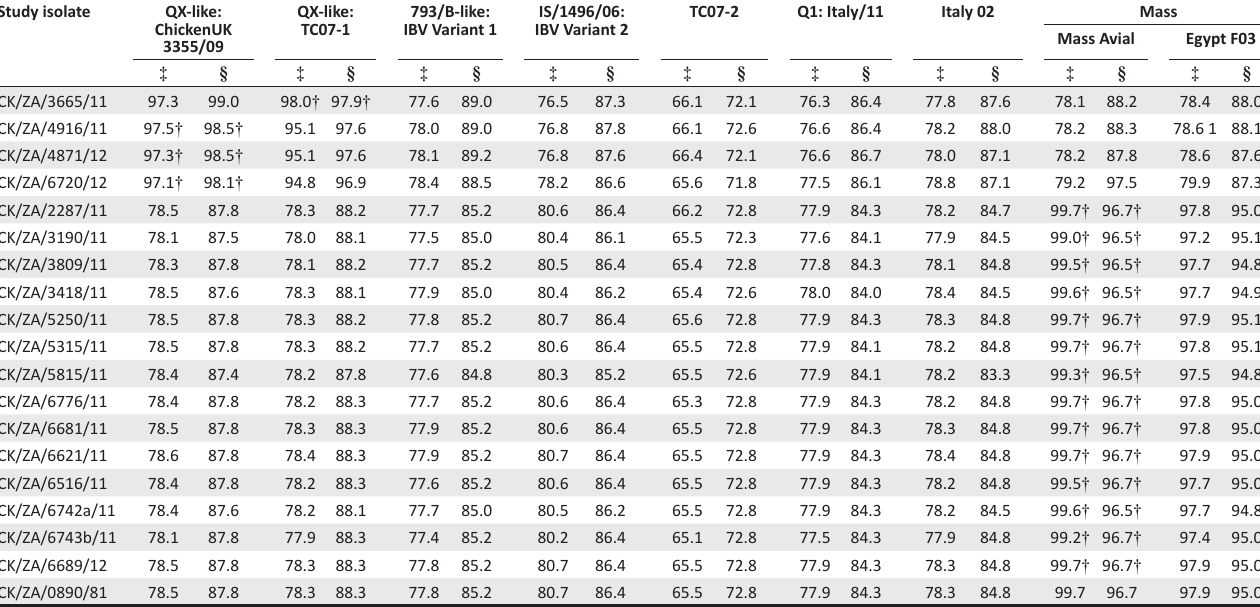
TABLE 3: Percentage similarity of study isolates with selected reference strains. Study